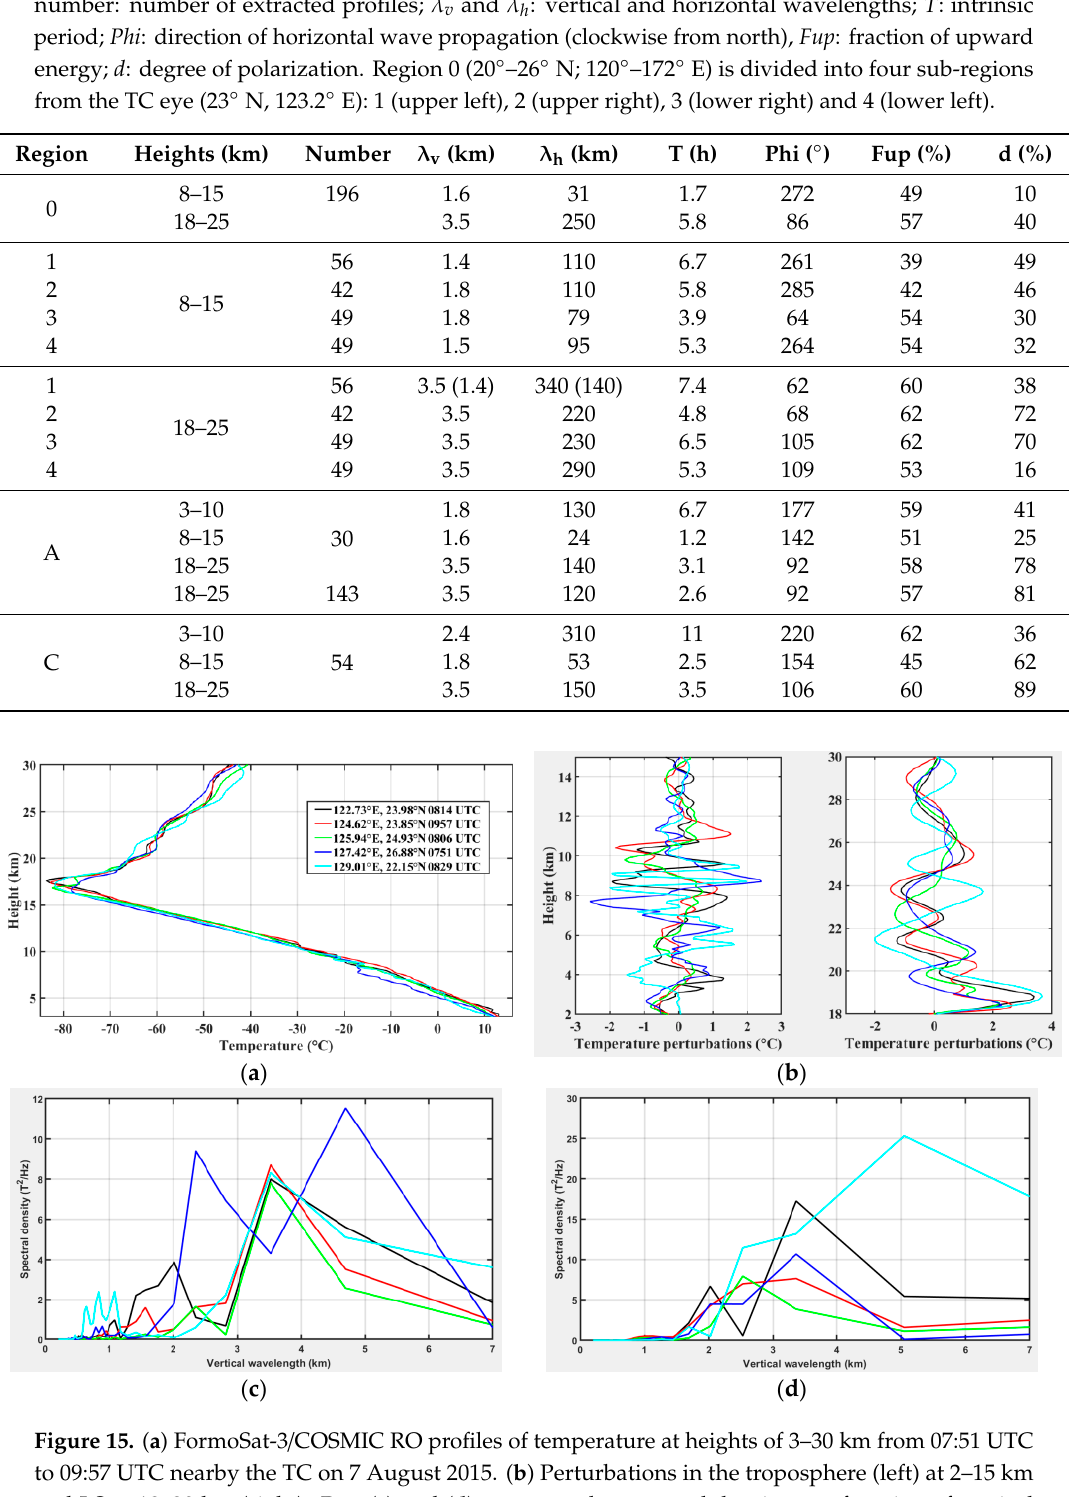
Figure 15. ( a ) FormoSat-3/COSMIC RO profiles of temperature at heights of 3–30 km from 07:51 UTC to 09:57 UTC nearby the TC on 7 August 2015. ( b ) Perturbations in the troposphere (left) at 2–15 km and LS at 18–30 km (right). Part ( c ) and ( d ) correspond to spectral density as a function of vertical wavelength respectively. For all figures, refer to colors in the legend of Figure 5a for the date and location of the RO profiles and also Figure 7a for the spatial distribution.